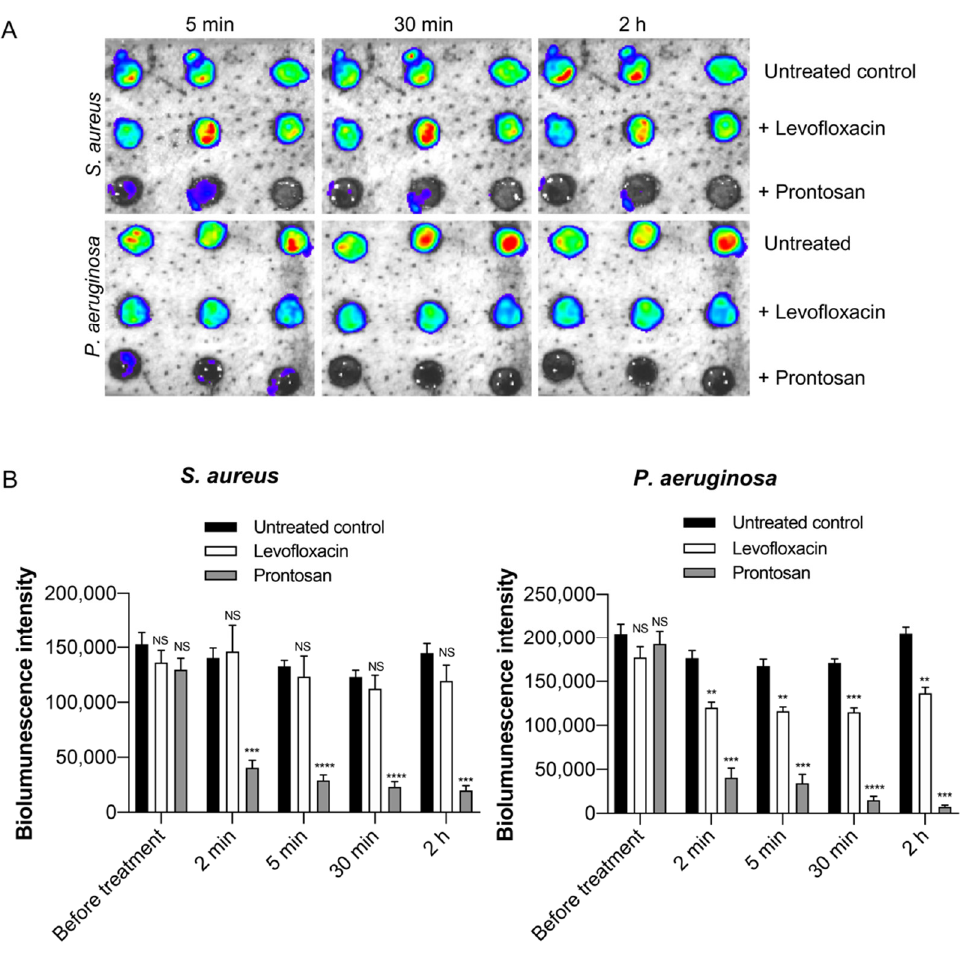
Figure 6. Longitudinal infection imaging of ex vivo wounds. ( A ) Wounds were infected with bio- luminescent strains of S. aureus or P. aeruginosa , incubated for two hours, and treated with the anti- microbial agents Prontosan or 2 µg/mL Levofloxacin. Bacterial bioluminescence intensity was non- invasively analyzed using the IVIS bioimaging system. Representative images show bacterial lu- minescence. ( B ) The bar chart shows measured bioluminescence intensity emitted by the bacteria. Data are represented as the mean ± SEM ( n = 4). P values were determined using a two-way ANOVA with Tukey test. Each group is compared to their respective untreated controls. Signifi- cant results are denoted as ** p < 0.01, *** p < 0.001, and **** p < 0.0001. NS, not